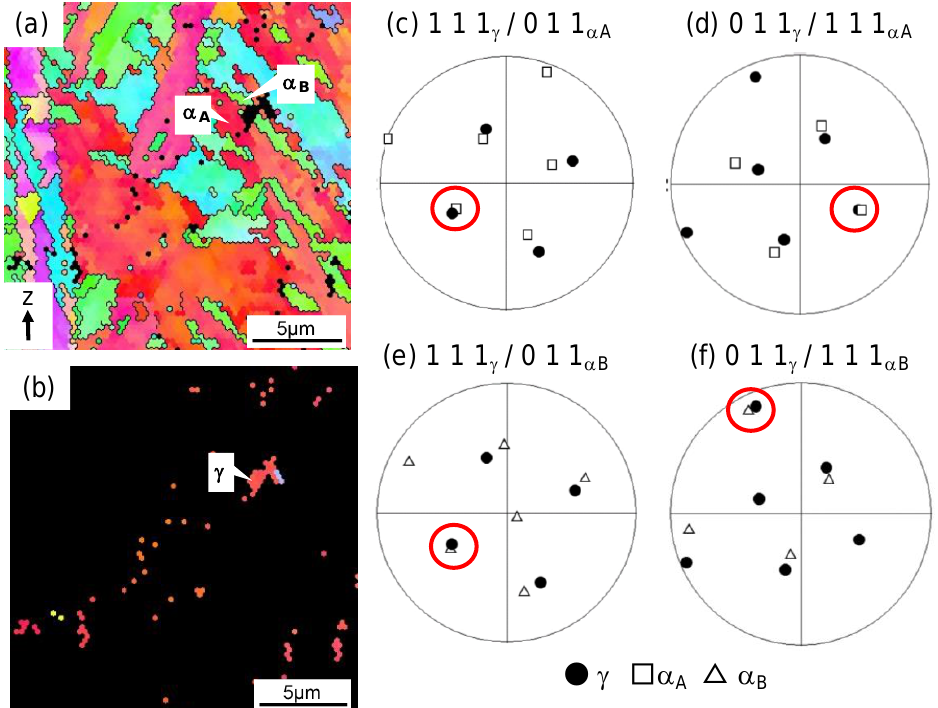
Figure 6. High-magnification orientation color maps in the ( a ) α and ( b ) γ phases, ( c – f ) stereographic projections of the ( c , e ) 111 γ /011 α and ( d , f ) 011 γ /111 α poles. The orientation of the γ phase was extracted from the γ grains depicted in ( b ). The α A and α B grains adjacent to the γ grain are indicated in ( a ).